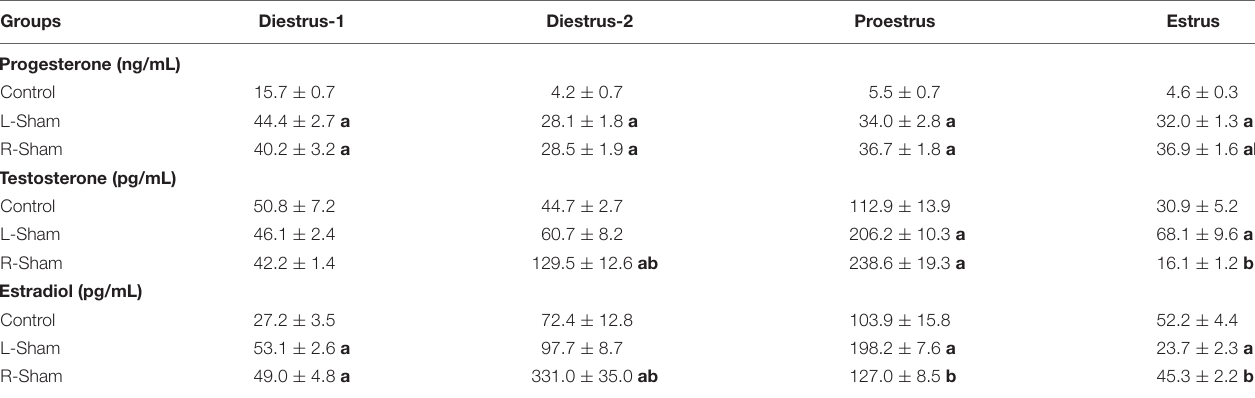
TABLE 1 | Means ± SEM of progesterone, testosterone and estradiol serum levels in control rats and animals with left or right sham surgery (L-Sham or R-Sham) performed to 10:30 h on diestrus-1, diestrus-2, proestrus, or estrus, sacrificed 1 h later. Groups Diestrus-1 Diestrus-2 Proestrus